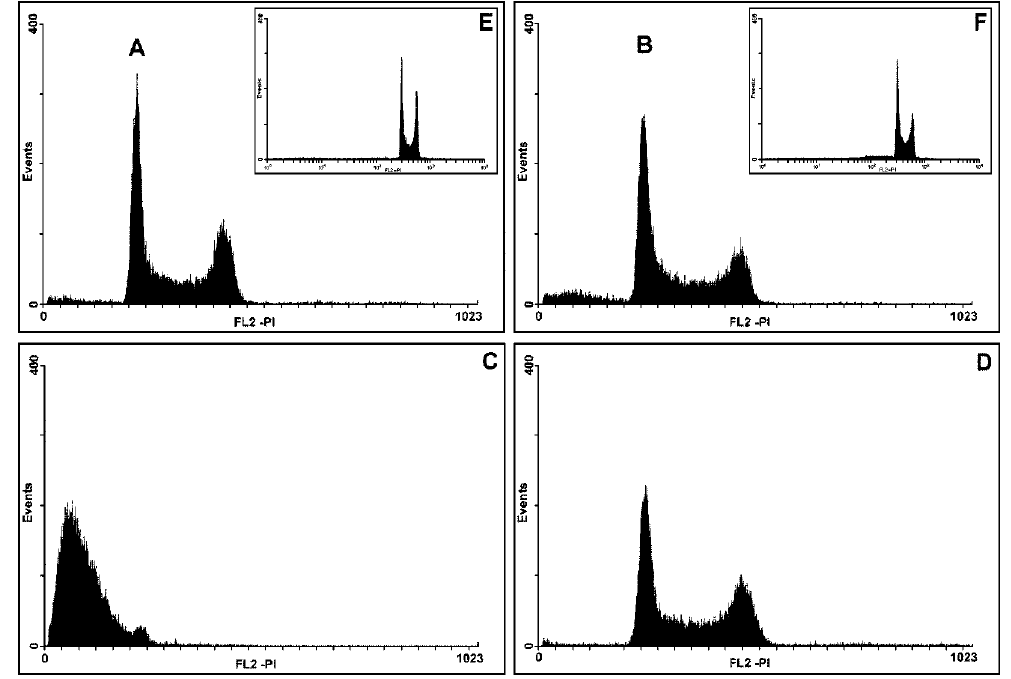
Fig. 6. Propidium iodide fluorescence (DNA content) histograms of HL60 cells after exposure to UV irradiation. A, control culture (non-irradiated). B, C and D, cells irradiated for 3 sec, 15 sec and 15 min, respectively. These irradiation times are representative of the other times depicted in the text. E and F, same as A and B but using logarithmic amplification. One representative experiment out of three is shown.